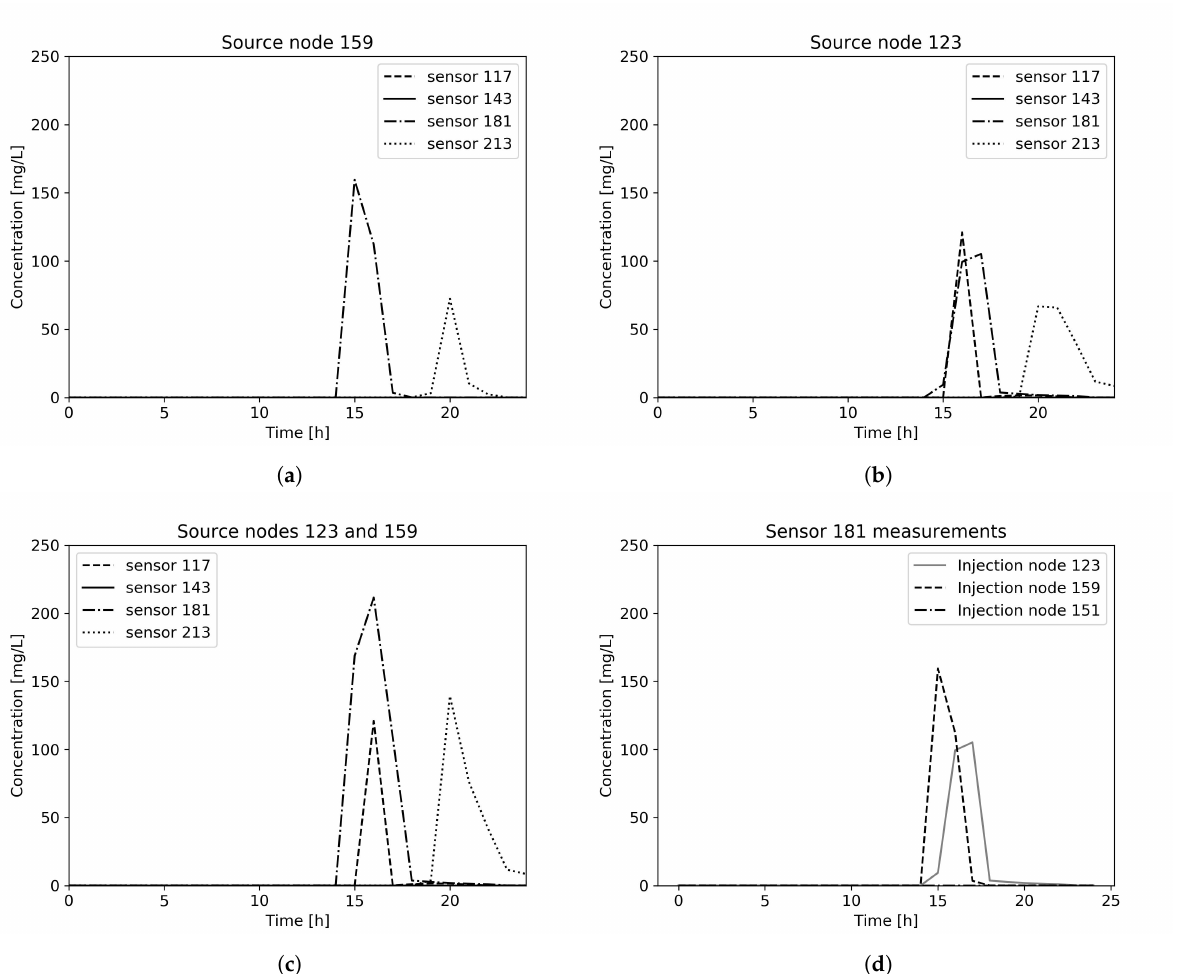
Figure 4. Sensor measurements for Net3 contamination scenario with ( a ) injection node 159, ( b ) injection node 123, ( c ) injection nodes 123 and 159 and ( d ) contamination measurements in the sensor in node